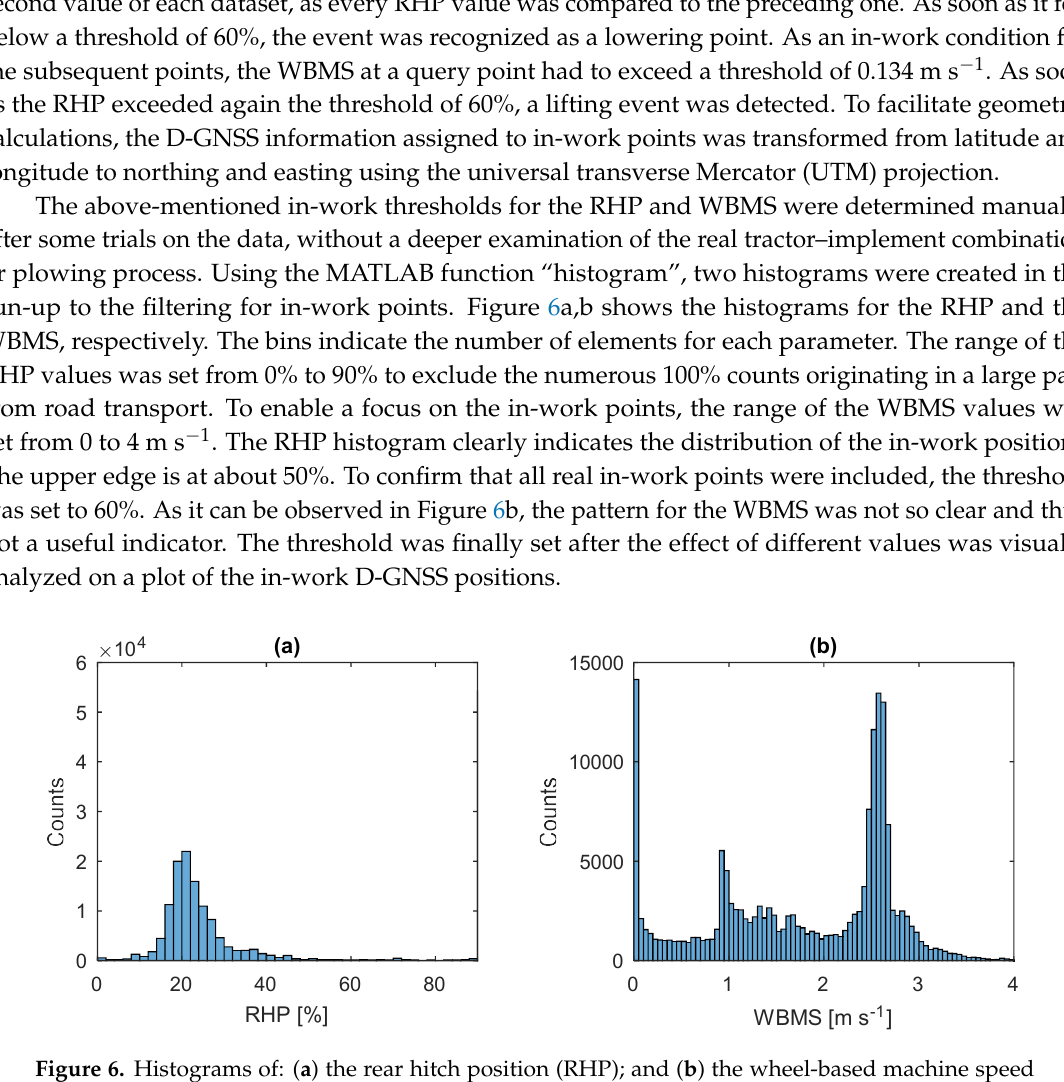
Figure 6. Histograms of: ( a ) the rear hitch position (RHP); and ( b ) the wheel-based machine speed (WBMS).